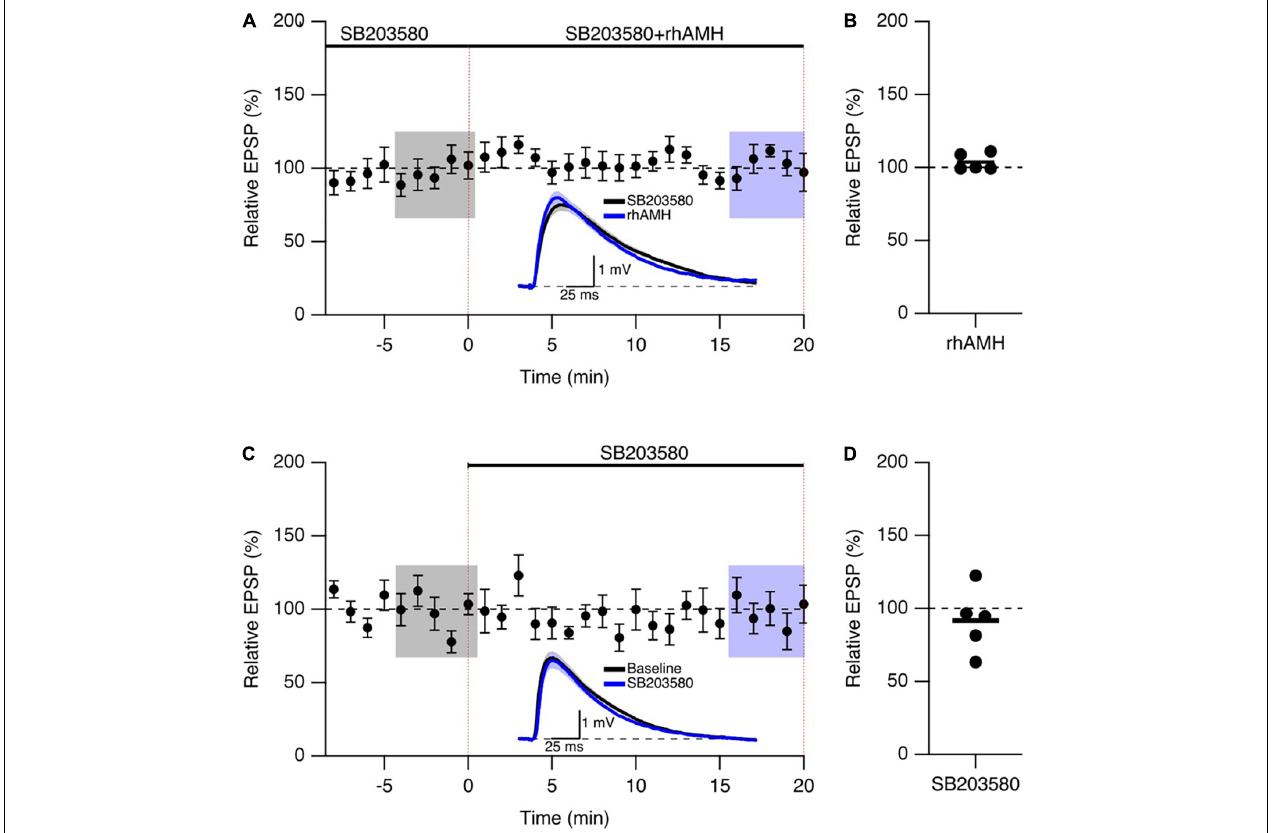
FIGURE 7 | The phosphorylation of Kv4.2-containing channels by p38 mitogen-activated kinase (MAPK) contributes to the AMH boosting of synaptic responses. (A) Summary time course plots of evoked EPSP amplitudes in the presence of 10 µ M SB203580 at –10–0 min and bath application 0.4 nM rhAMH at 0–20 min. The rhAMH addition did not increase EPSPs in the presence of SB203580. Data are binned into 1 min intervals. Representative voltage traces (average of 15 EPSPs) were acquired in the absence (black) and presence (blue) of rhAMH for individual neurons. (B) Summary scatterplot of relative EPSP amplitude during rhAMH addition in the presence of MAPK inhibitor SB203580. (C) Summary time course plots of evoked EPSP amplitudes in the presence control aCSF and bath application 10 µ M SB203580 at 0–20 min. The SB203580 addition did not increase EPSPs. (D) Summary scatterplot of relative EPSP amplitude during SB203580 addition in control